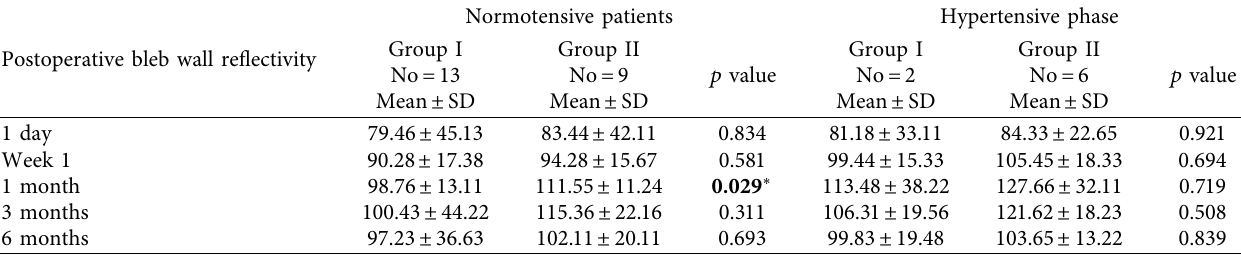
Table 5: Maximal bleb wall reflectivity of the studied groups.